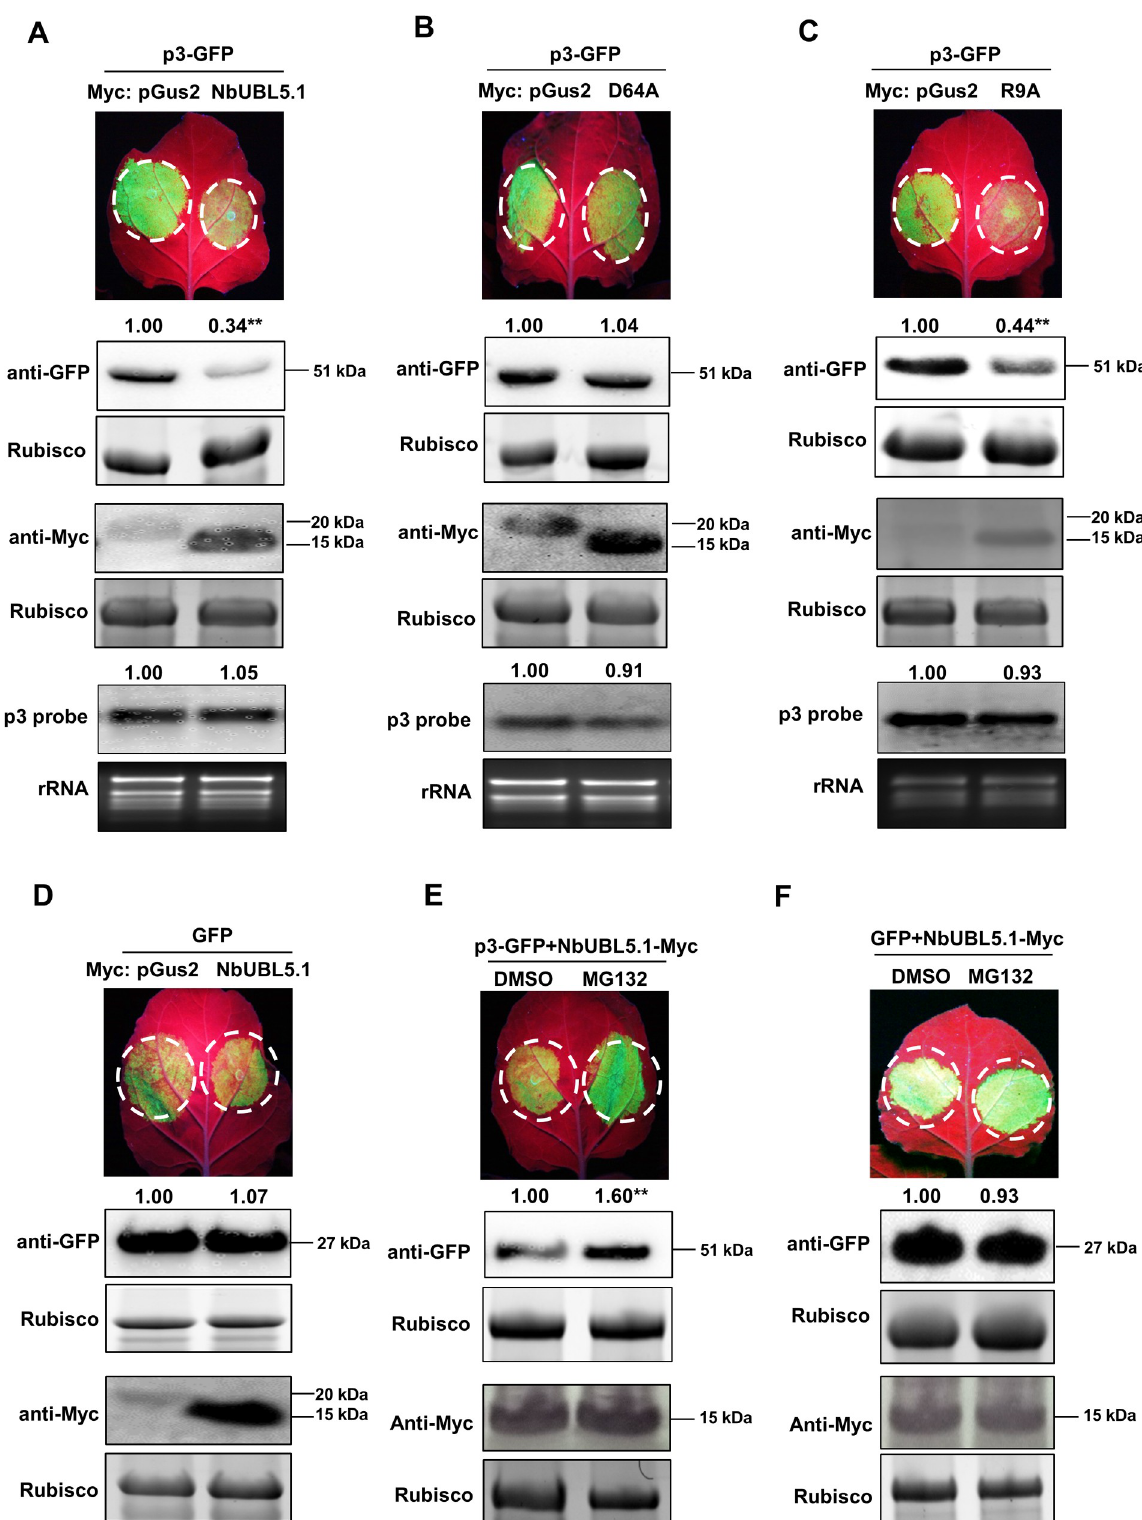
Fig 4. NbUBL5.1 mediates p3 degradation through the 26S proteasome system. A. GFP-fused p3 was co-expressed with Myc-fused NbUBL5.1 or Myc-fused pGus2 as control in leaves of wild type N . benthamiana through agroinfiltration. At 3.5 dpi, fluorescence